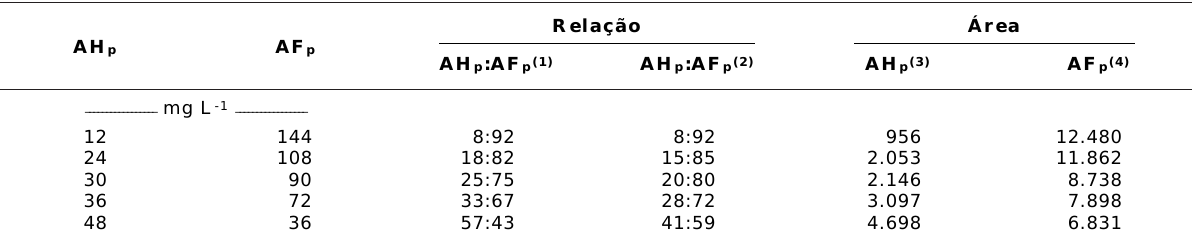
(1) Relações teóricos obtidas via uso de diferentes concentrações de AH de